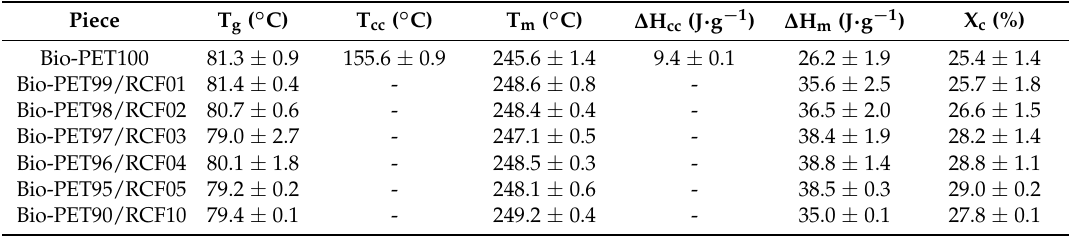
Figure 3. Differential scanning calorimetry (DSC) curves during second heating of the bio-based polyethylene terephthalate (bio-PET)/recycled cotton fiber (RCF) composite pieces. Table 3. Summary of the main thermal properties of the bio-based polyethylene terephthalate (bio-PET)/recycled cotton fiber (RCF) composite pieces in terms of: glass transition temperature (T g ), cold crystallization temperature (T cc ), melting temperature (T m ), cold crystallization enthalpy ( Δ H cc ), melting enthalpy ( Δ H m ), and degree of crystallinity (X c ).